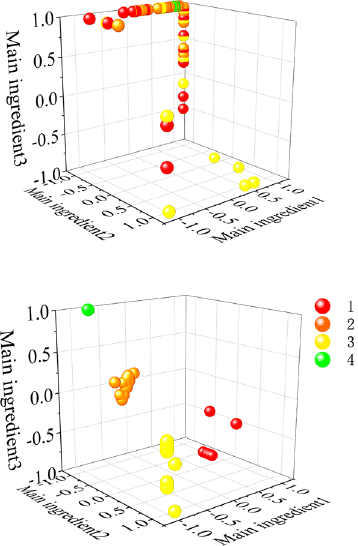
Figure 4. Visualization of bearing fault data of Case Western Reserve